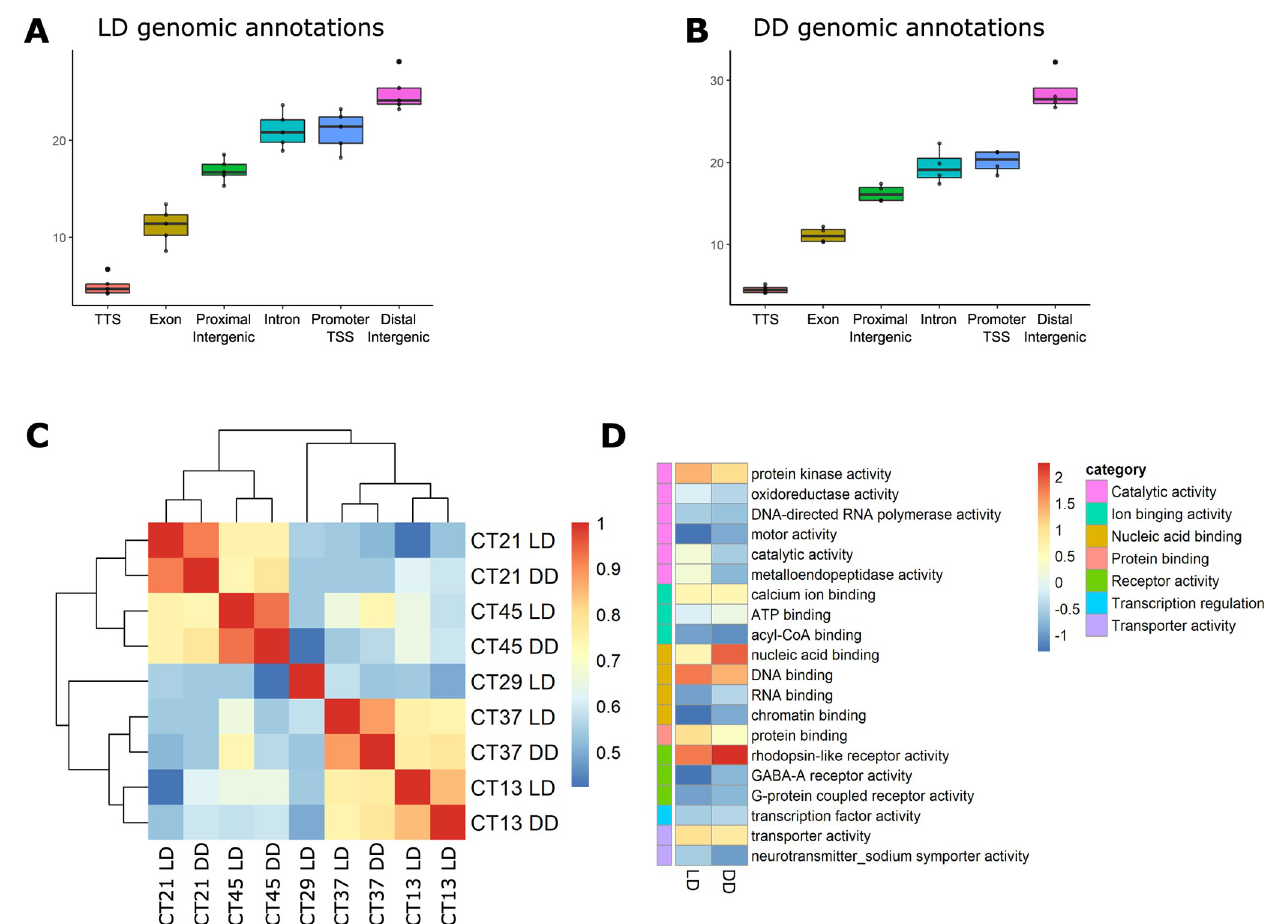
Fig 2. (A) Boxplot representing the percentage of genomic features of LD-treated Nematostella vectensis , calculated from biological replicates across experimental sampling points (n = 5). (B) Boxplot representing the percentage of genomic features of DD-treated Nematostella vectensis calculated from biological replicates across experimental sampling points (n = 4). (C) ATAC-seq signal within consensus ATAC-seq peaks was compared between all samples, using Spearman’s ρ to cluster samples. (D) Comparison of GO annotations associated with accessible promoters identified from each library. The degree of enrichment is indicated using normalized